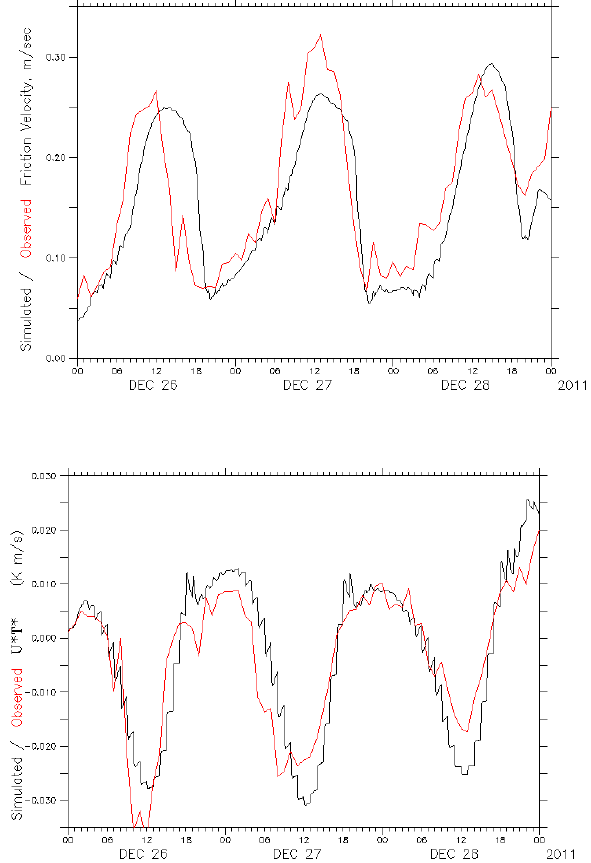
Figure 5. Surface turbulent fluxes at the Dome C tower, as a func- tion of Local Time LT (Universal Time UT + 8h). Panel (a) refers to the friction velocity, and panel (b) to the sensible heat flux u * T *. The dark line is the MAR simulation, the red line the ISAC obser-